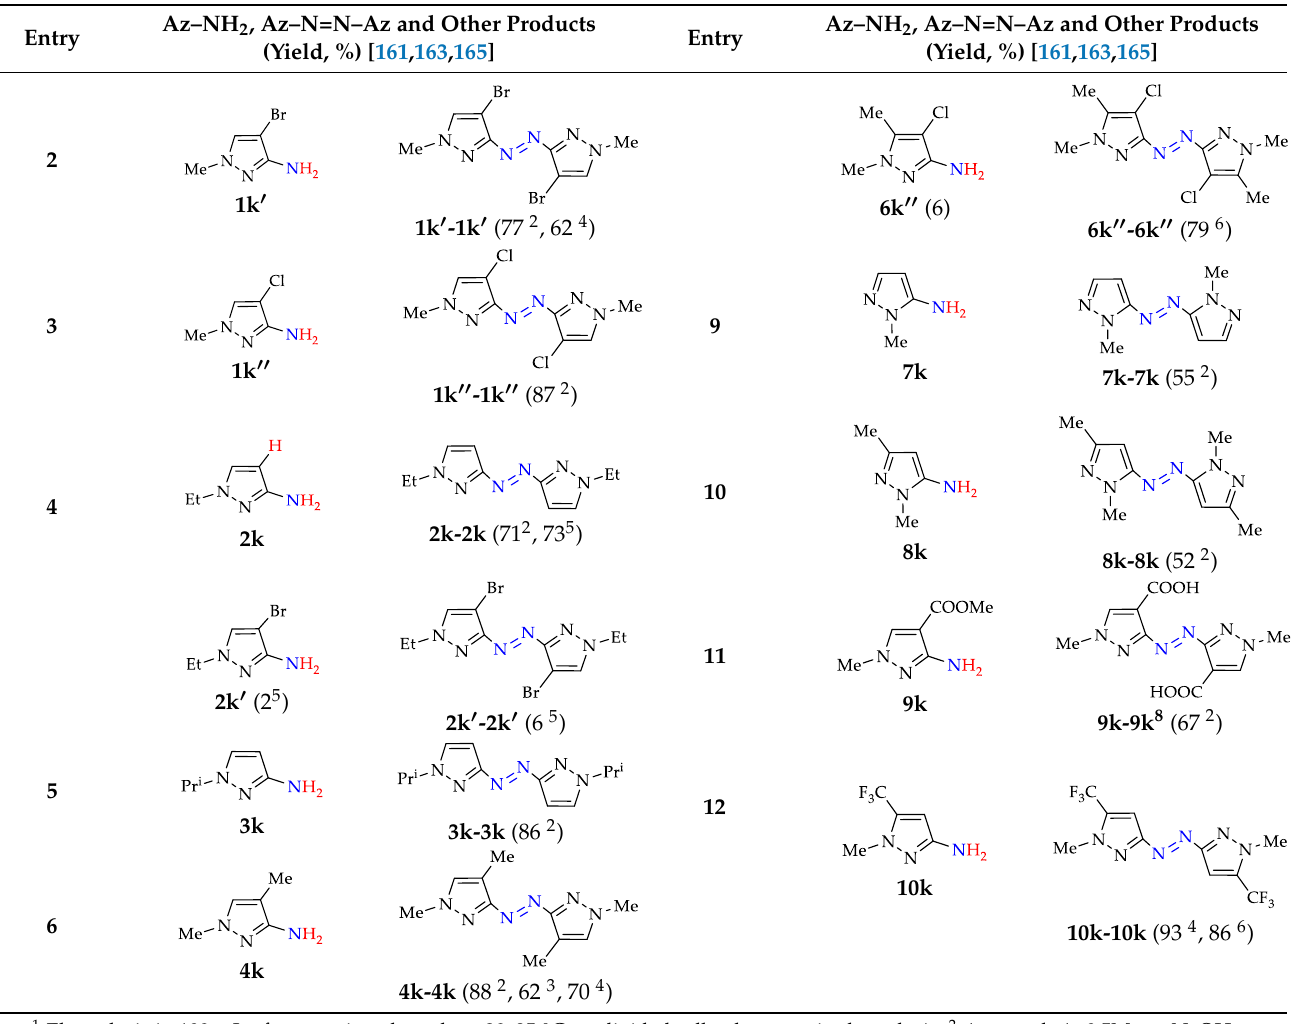
Table 7. N – N cross-coupling of aminopyrazoles (Az – NH 2 ) using approach A 1 .